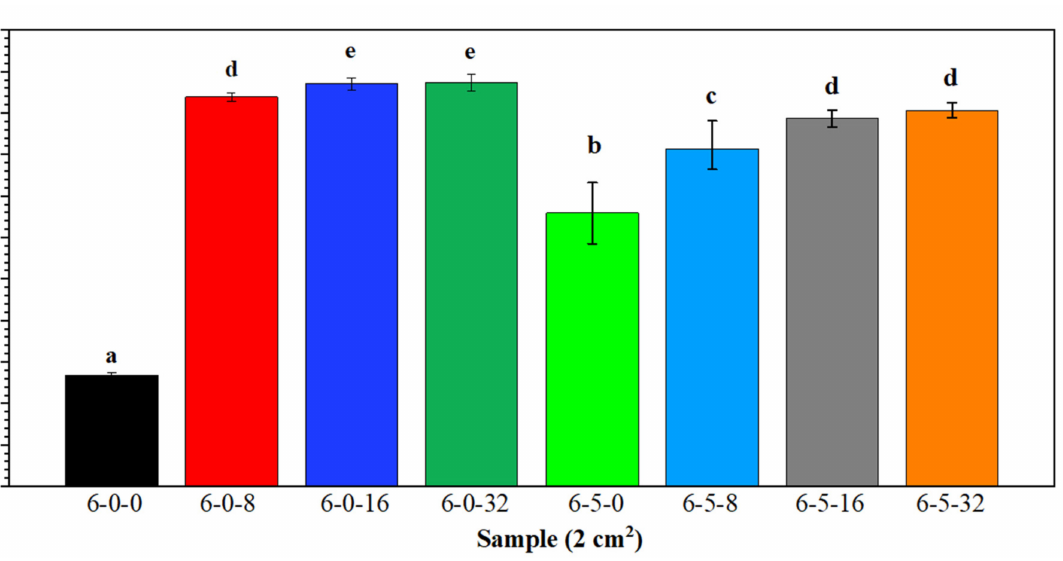
Figure 8. Anti-inflammatory activity of PVA/HC/EEHP electrospun membranes (Nomenclature: % PVA (6)—% hydrolyzed collagen (0, 5)—% EEHP (0, 8, 16,